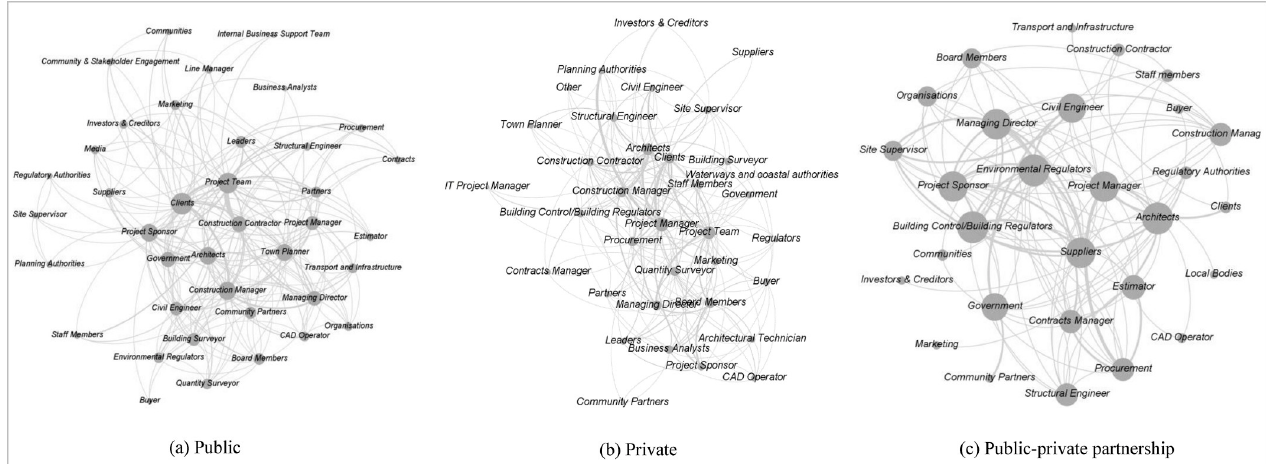
Fig 7. Visualizations of the three aggregated networks: (a) public, (b) private, and (c) public-private partnership. The size of a node proportionates to its degree centrality value. The thickness of an edge proportionates to its edge weight.